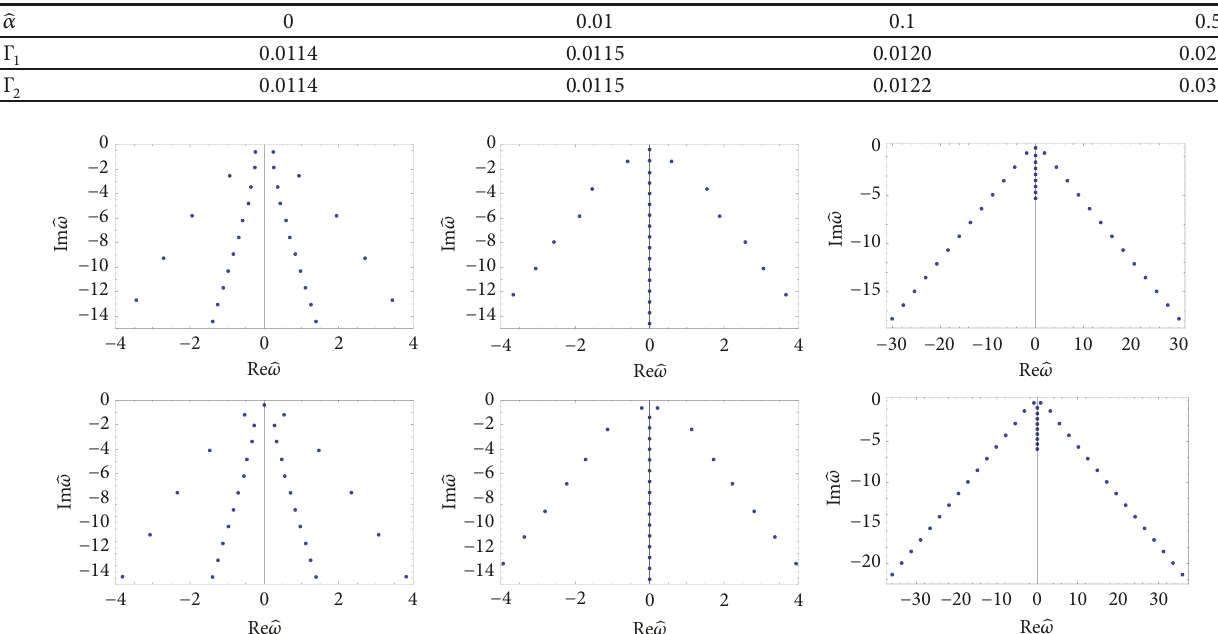
Table 1: The relaxation rate Γ 𝑖 of the holographic system with 𝛾 1 = −1 for different ̂𝛼 . Γ 1 is fitted by the Drude formula (21) and Γ 2 is obtained by locating the position of the purely imaginary mode in complex frequency panel.